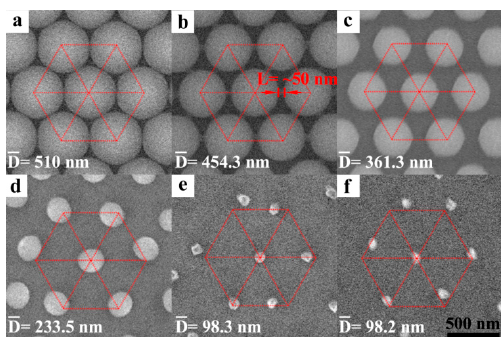
Figure 1. Scanning electron microscopes (SEM) images of polystyrene (PS) nano-spheres during the plasma etching. ( a ) Close-packed PS nano-sphere array before plasma etching. Images of the PS nano-spheres when they were etched for ( b ) 5 min, ( c ) 10 min, ( d ) 15min ( e ) 20 min, and ( f ) 25 min, respectively. The measurements were carried out by the best-fit circle tool of the Image-Pro Plus software and 10 nano-spheres were measured for each experiment to minimize random errors. The mean value was used to represent the diameter of nano-spheres. The hexagon in red demonstrates the original lattice of self-assembled PS nano-spheres. A bridge between the neighboring PS nano-spheres in ( b ) was marked in